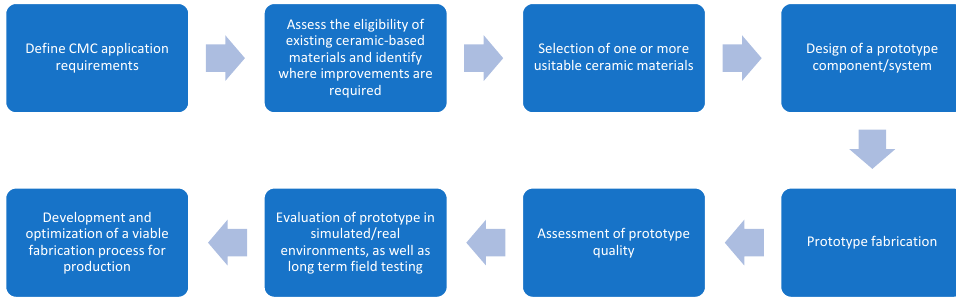
Figure 19. CMC development process steps.